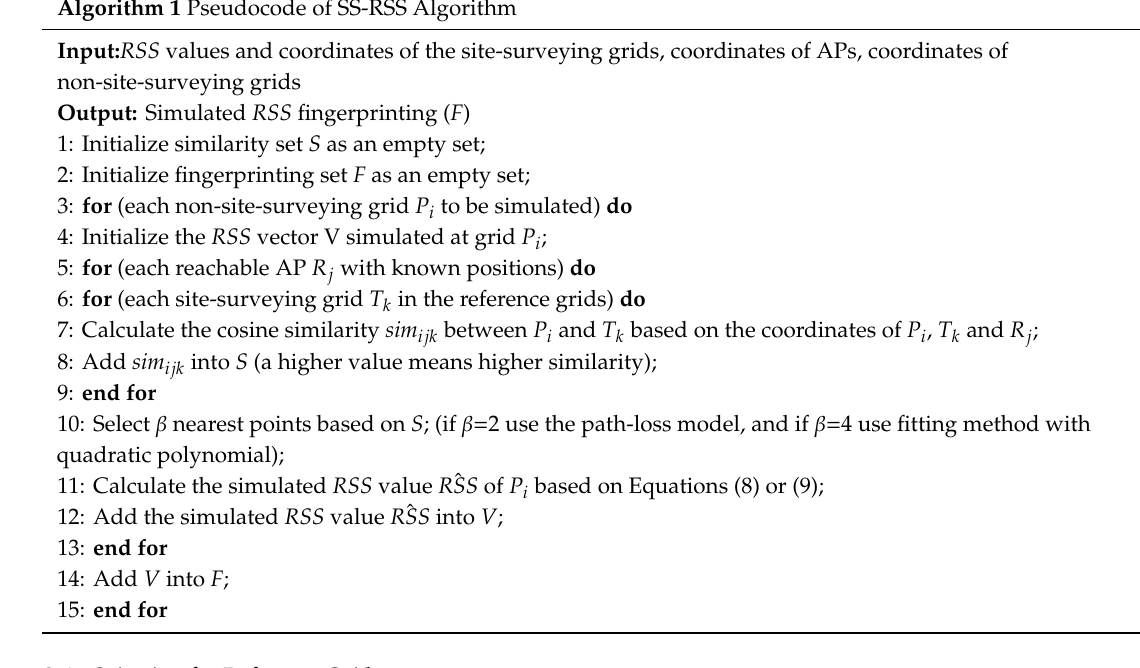
Algorithm 1 Pseudocode of SS-RSS Algorithm Input: RSS values and coordinates of the site-surveying grids, coordinates of APs, coordinates of non-site- surveying grids Output: Simulated RSS fingerprinting ( F )